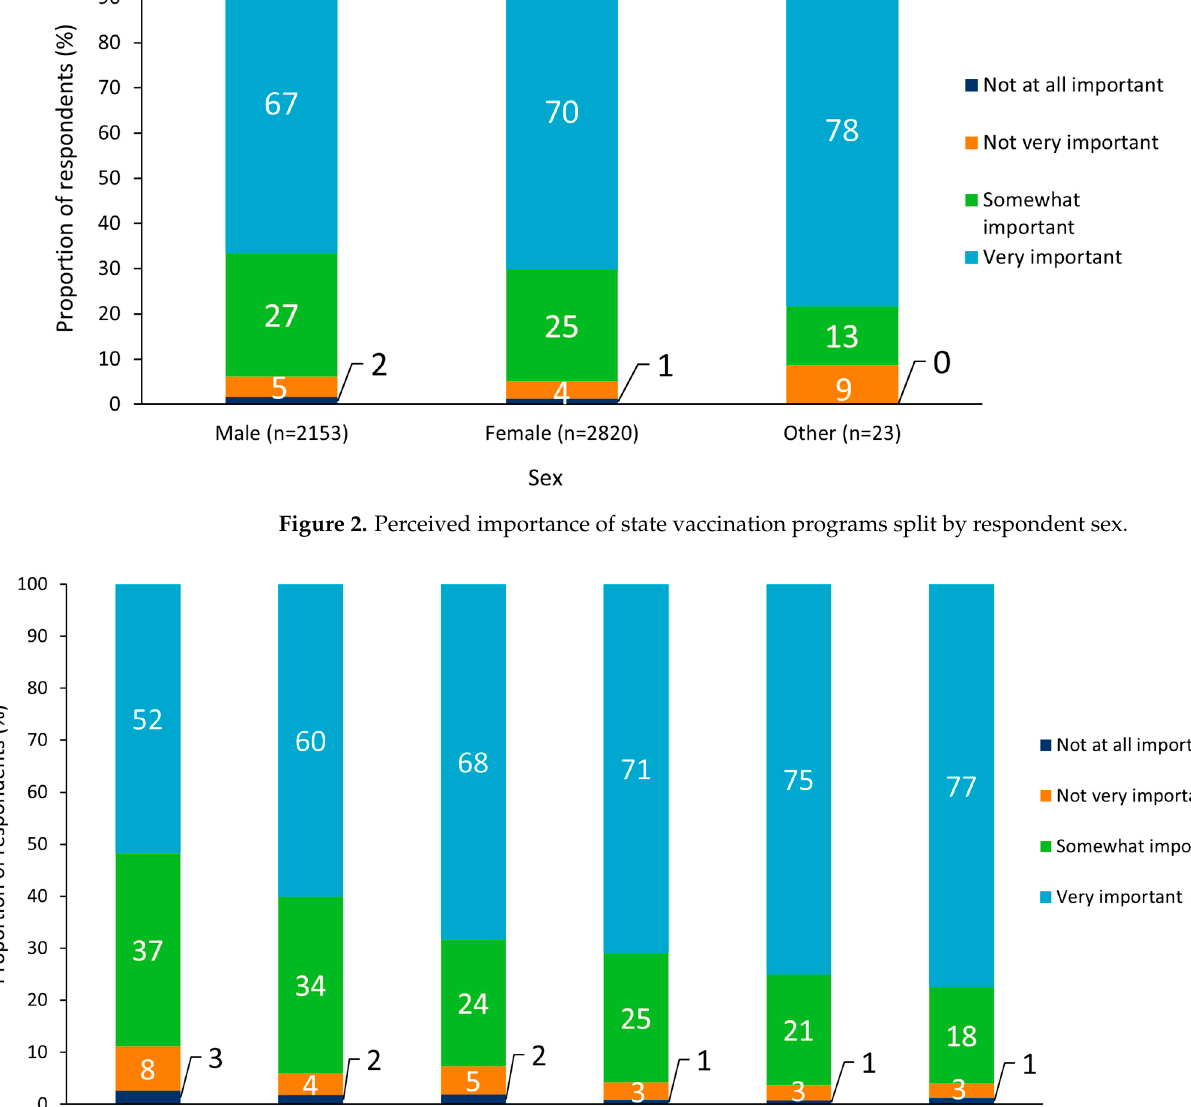
Figure 1. Perceived importance of state vaccination programs for all respondents (n = 5000) Results split by US region.